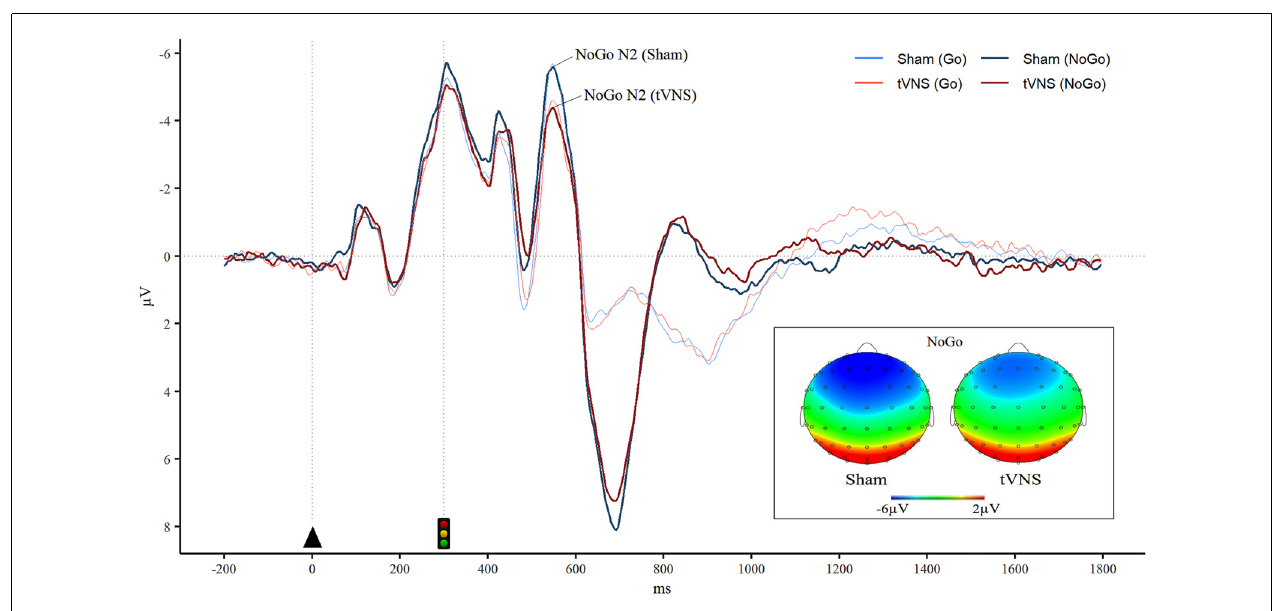
FIGURE 2 | Reduced frontal NoGo-N2 during tVNS. Grand averaged event-related potentials (ERPs) in the frontal region (averaged over F1, F2, F3, and F4 electrodes) illustrates significantly diminished NoGo-N2 ERP peak amplitude during tVNS. Furthermore, brain topography maps in the NoGo condition during tVNS and sham stimulation show reduced frontal negativity in the N2 time window during tVNS in comparison to sham